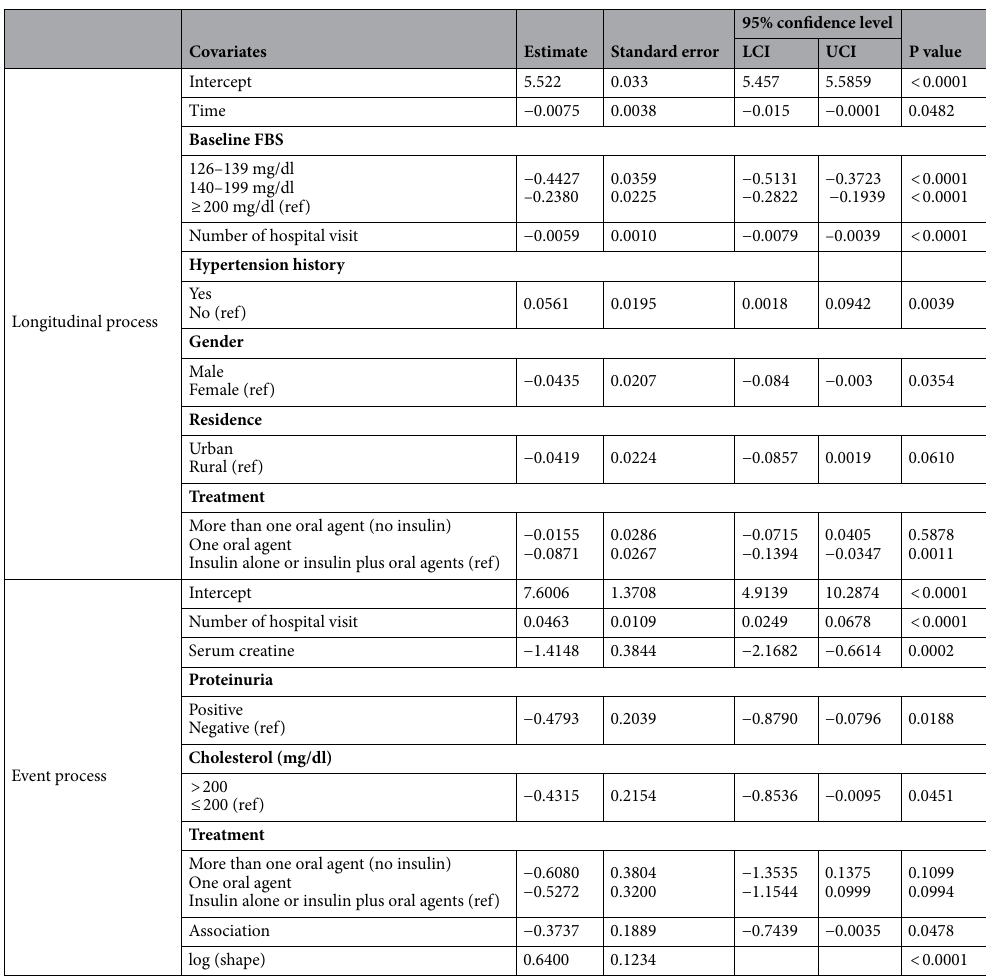
estimate − estimate . ref = reference